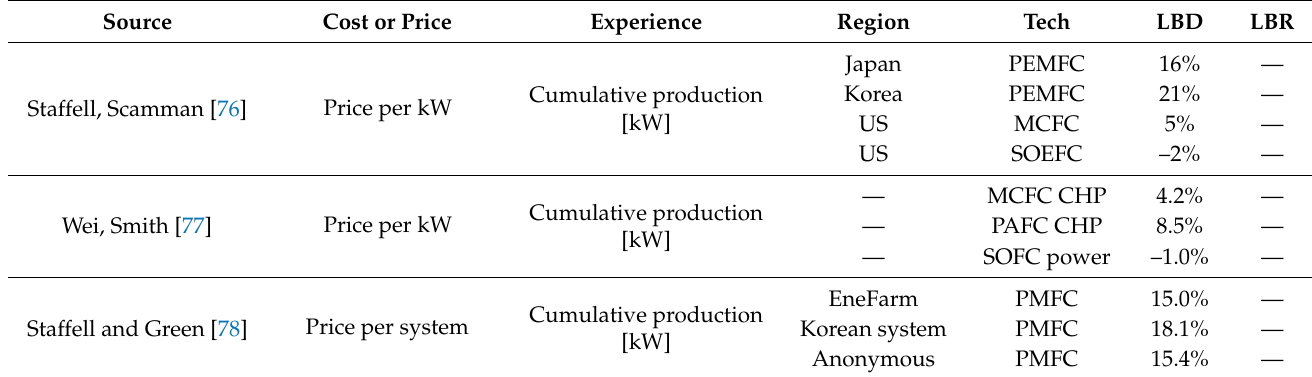
Table A4. LRs for hydrogen fuel cells.